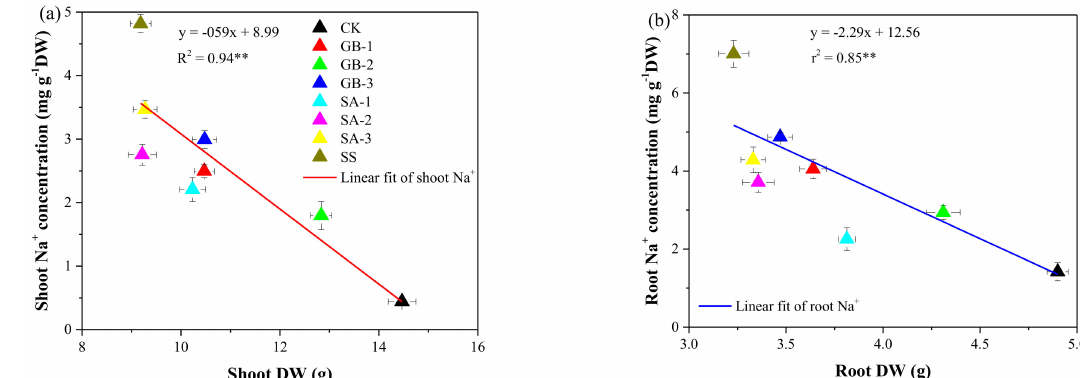
Figure 5. Relationship between ( a ) shoot Na + concentration and shoot dry weight (DW), and ( b ) root Na + concentration and root DW. Treatments: CK, control; GB2.5, 2.5 mM GB; GB5.0, 5.0 mM GB; GB7.5, 7.5 mM GB; SA1.0, 1.0 mM SA; SA1.5, 1.5 mM SA; SA2.0, 2.0 mM SA; SS, salt stress (150 mM) without supplementation. Values are means (n = 3), and error bars represent standard deviations; * and ** indicate significance levels of p < 0.05 and p < 0.01,